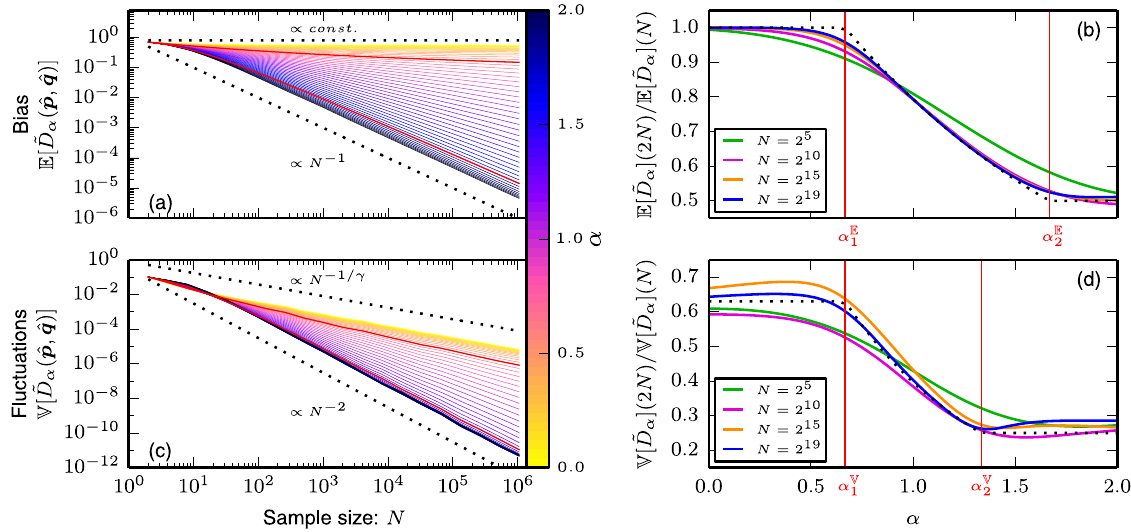
~ D ˆ p ; ˆ q Þ(cid:3) between two sequences, each of E ½ ~ D FIG. 5. Bias (a,b) and fluctuations (c,d) in the finite-size estimation of α . Estimation of α ð size N , drawn numerically from the same power-law distribution p i ∝ i − γ for i ¼ 1 ; 2 ; … ; V → ∞ with γ ¼ 3 = 2 using the plug-in ~ D estimator ( p i ↦ ˆ p i ) for the entropies of order α . (a) Scaling of the bias with N for different α . (b) Decrease of the bias in α when the sample size is doubled ( N ↦ 2 N ) for different values of N as a function of α . (c,d) The same as (a) and (b) for the fluctuations ˆ p ; ˆ q Þ(cid:3) . Red lines in all plots indicate the borders between the regimes, α E 1 = γ ¼ 2 = 3 , α E 1 þ 1 = γ ¼ 5 = 3 [for the bias in (a,b)] V ½ ~ D α ð 1 ¼ 2 ¼ and α V 1 ¼ 1 = γ ¼ 2 = 3 , α V 2 ¼ 1 þ 1 = ð 2 γ Þ ¼ 4 = 3 [for the fluctuations in (c,d)]. Dotted lines indicate the predictions based on Table I for α V α > α E α V α [in (b,d)]. Averages are taken over 1000 α < α E 1 , 1 and 2 , 2 [in (a,c)] and all values of